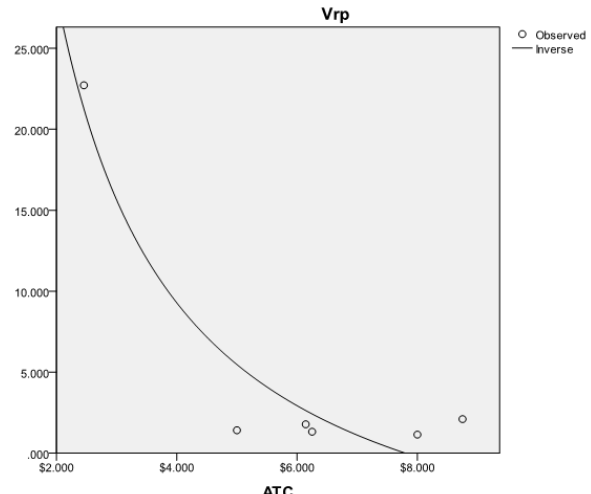
Fig. 1. Number of visits per population (Vrp) and adjusted travel cost (ATC)